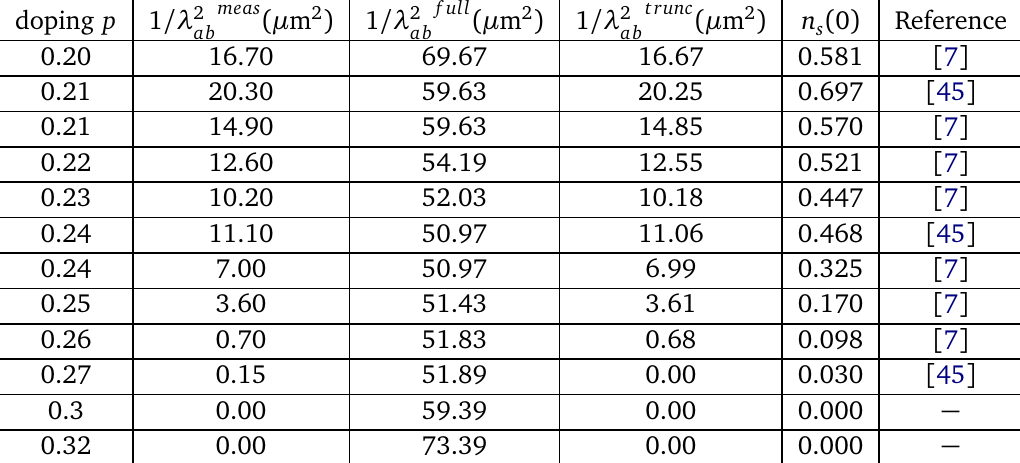
Table 10: Measured and calculated 1 /λ 2 (0) values for a full and truncated FS in OD ab ( 0 ) is the estimated superfluid density (per Cu site) obtained as described LSCO. n s in the text. For p = 0.27, the model was unable to reach the experimentally deter- ( 0 ) is calculated using the London equation with mined penetration depth. Thus, n s m ∗ = 8.2 where m ∗ is estimated from the as-measured electronic specific heat [ 7,45 ] . Obviously, no penetration depth results have been reported on the non-SC samples but they are included here for